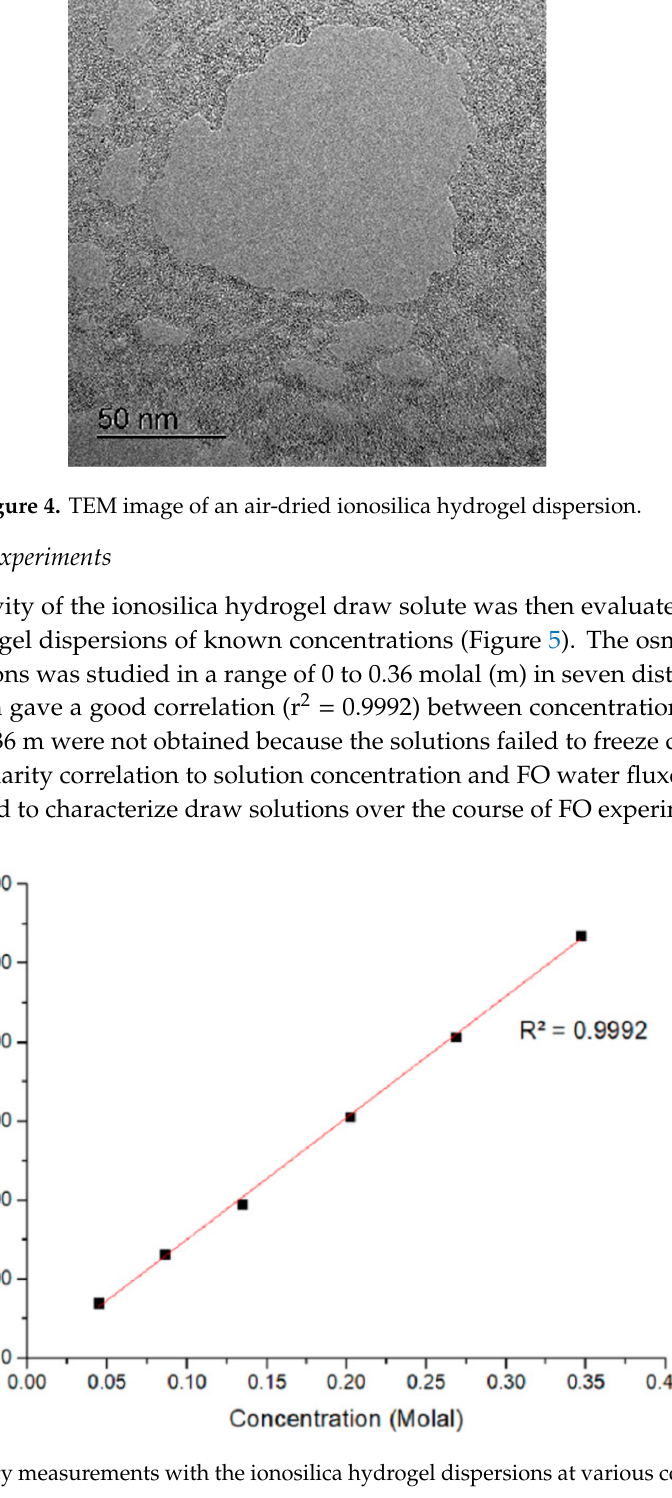
− 1 NaCl aq. feed. The semi-industrial FO pilot used in this